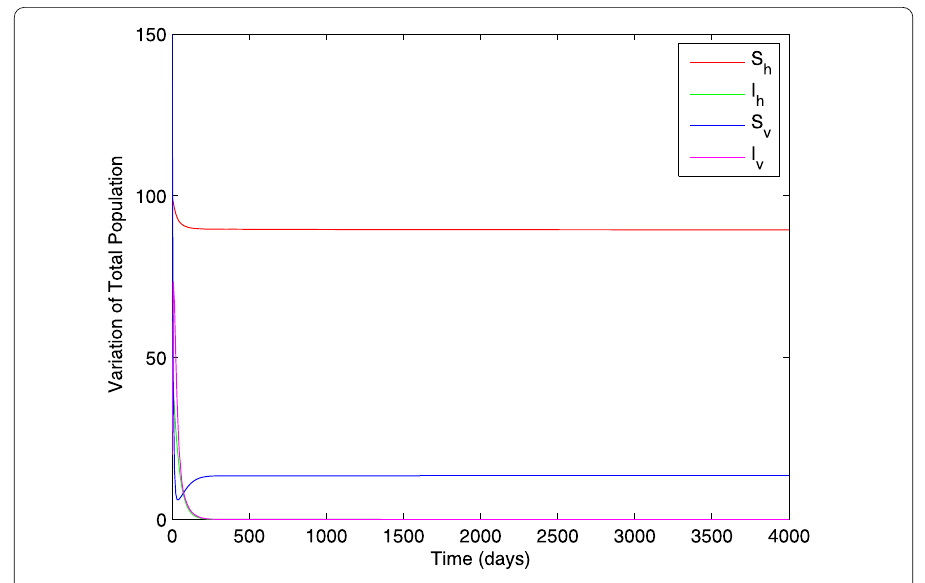
Figure 1 The Population approaches disease-free equilibrium when R 0 < 1.